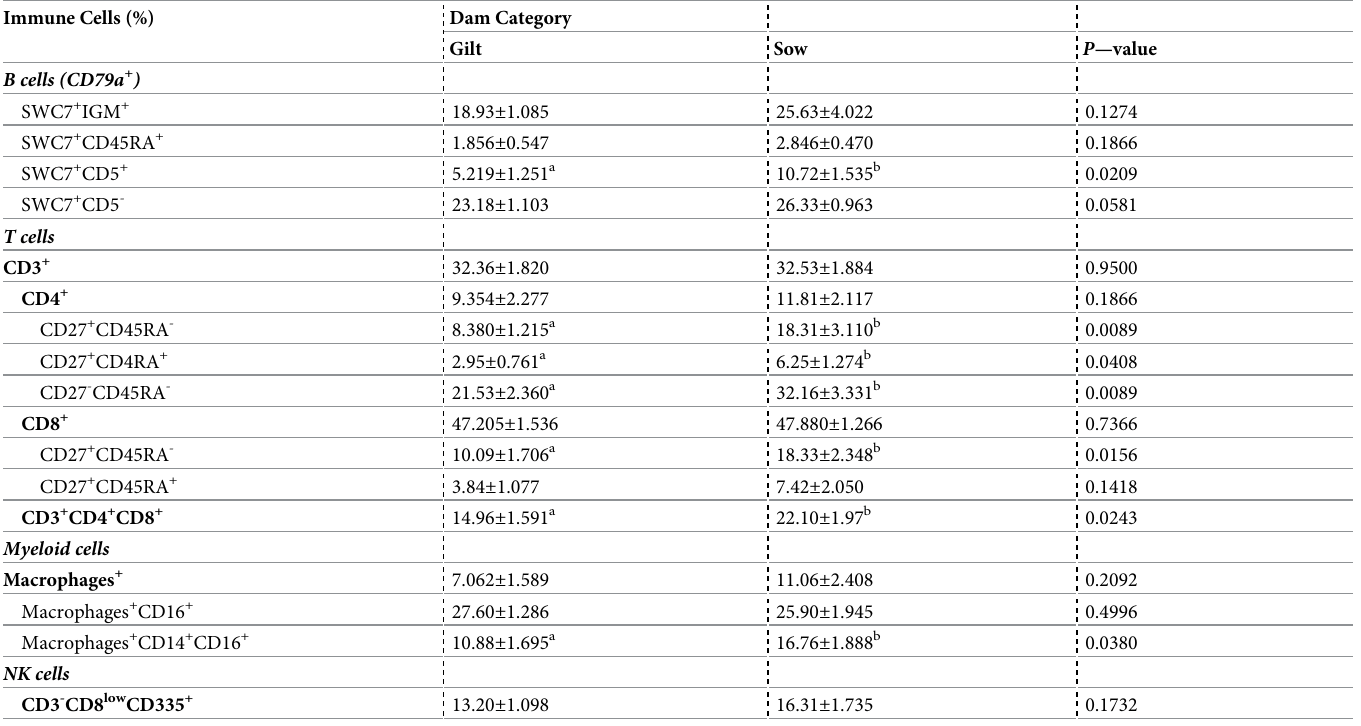
Table 2. Percentages of cells (T lymphocyte, B lymphocyte, and monocyte subsets) in colostrum from gilts and